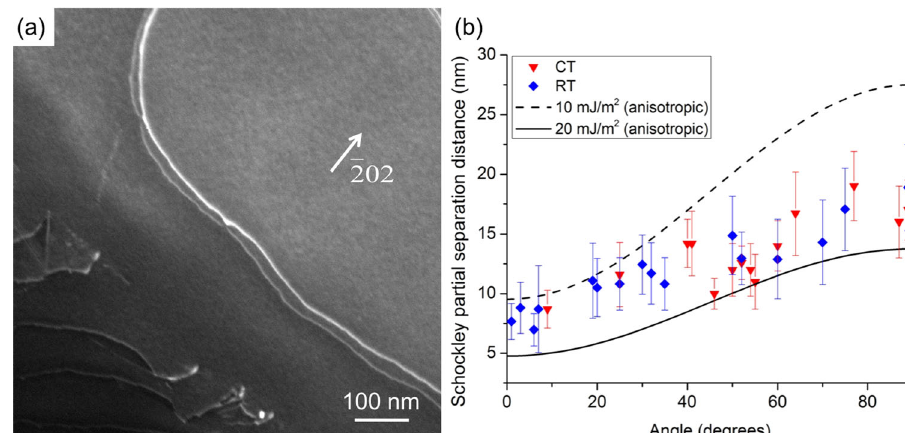
Fig. 1 Characterization of dissociated dislocations in equiatomic CrCoNi medium entropy alloy. a An example image showing both Shockley partial dislocations of a dissociated dislocation obtained by Weak beam dark fi eld scanning transmission electron microscopy (WB DF STEM); and ( b ) experimentally measured dissociation distances in equiatomic CrCoNi medium entropy alloy at room temperature (RT) condition and cryogenic temperature (CT) condition.